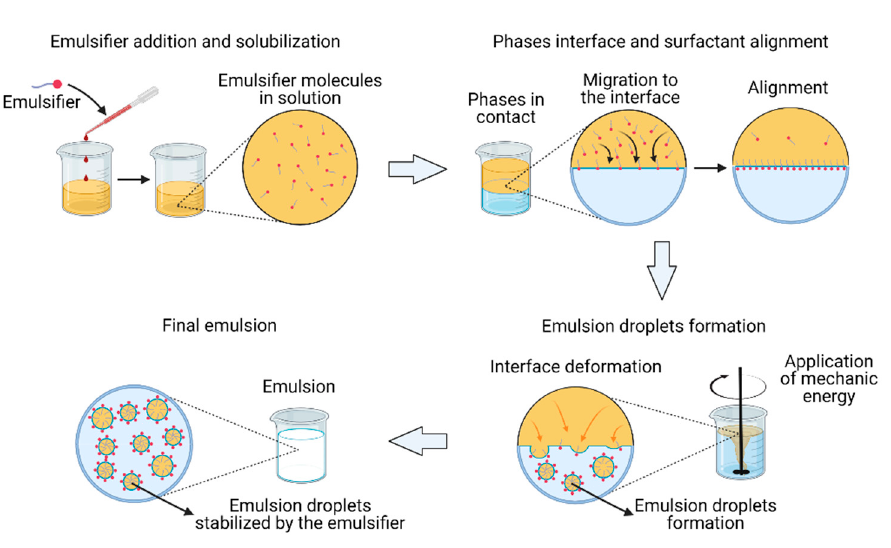
Figure 2. Process of emulsification. During the emulsifier addition and solubilization stage, the emulsifier is added to one of the phases and it dissolves homogeneously in the solution. Next, at the phases interface and surfactant alignment stage, emulsifier molecules migrate to the interface and align their moieties depending on their affinity. The reduction of the interfacial tension allows the interface to deform with the aid of mechanical forces, as shown at the emulsion droplets formation stage. Finally, droplets of one liquid inside the other are formed and stabilized, and therefore, the final emulsion is produced (created with BioRender®, San Francisco, CA, USA).